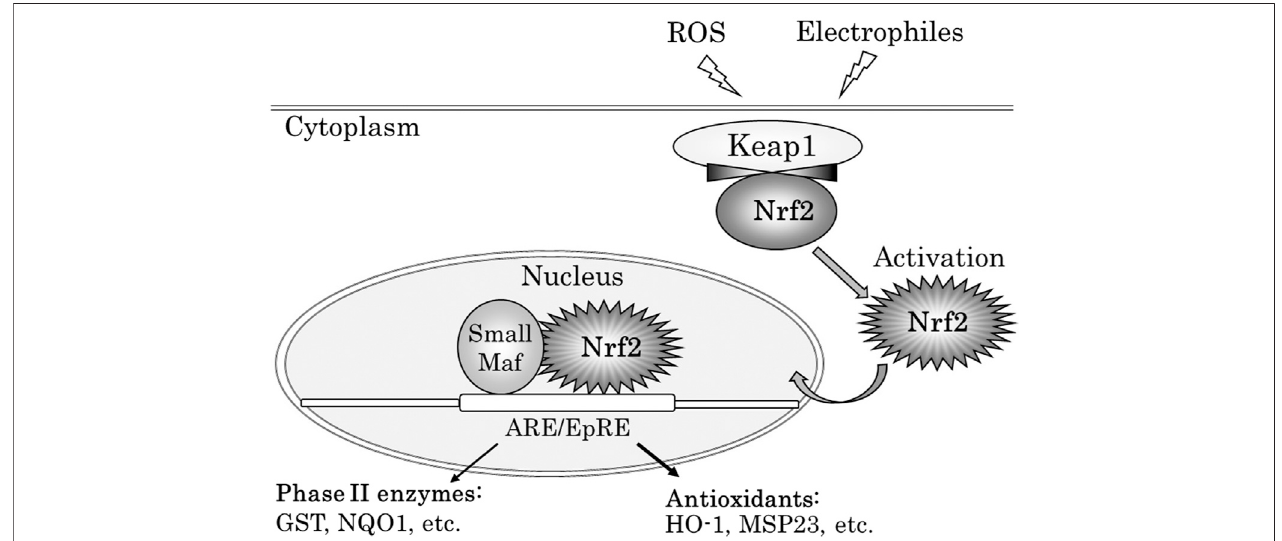
FIGURE1| ActivationofNrf2withROSorelectrophiles,andexpressionofPhaseIIenzymegenesandantioxidantstressproteingenes via ARE/EpRE.Undernon- stressedconditions,thetranscriptionfactorNrf2isconstitutivelydegradedbybindingtoKeap1.ROSorelectrophilicattackleadstothedissociationofNrf2fromKeap1. Activated Nrf2 protein is then translocated into the nucleus and many genes encoding detoxifying and antioxidant enzymes are expressed. ROS: reactive oxygen species,ARE:antioxidantresponseelement, EpRE:electrophileresponsive element,GST:glutathioneS-transferase,NQO1: NAD(P)H quinonedehydrogenase 1, HO-1: heme oxygenase-1, MSP23: macrophage 23-kDa stress